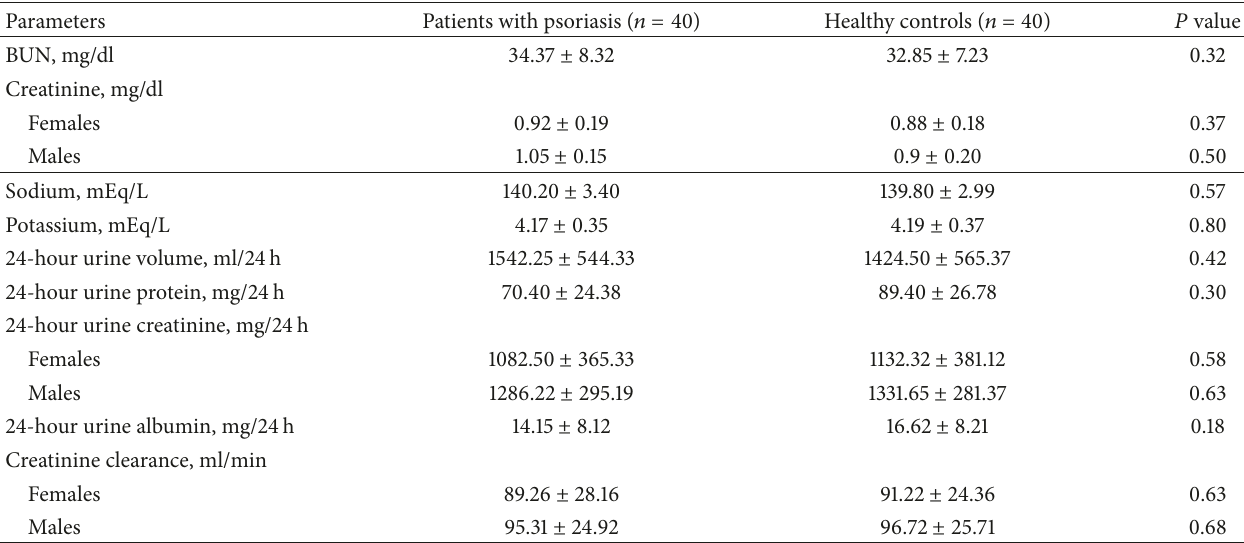
Table 2: Laboratory findings of patients with psoriasis and healthy